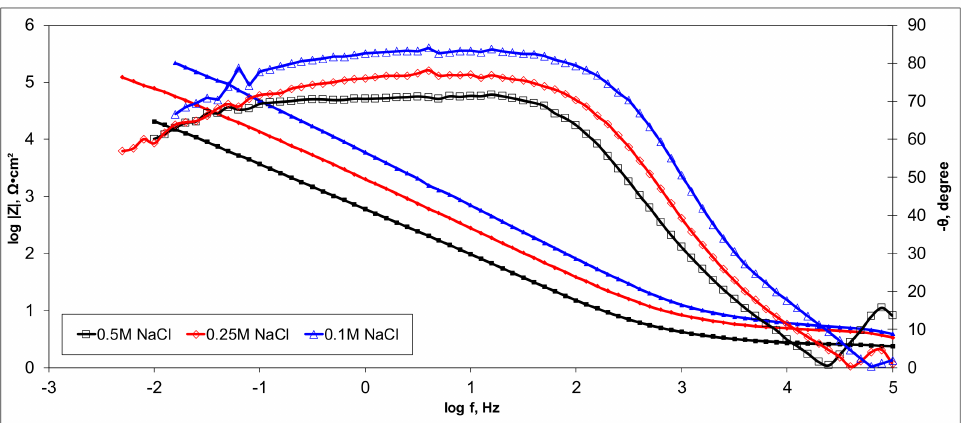
Figure 11. Bode plots for the X1 variant in NaCl: 0.5M, 0.25M, 0.1M.